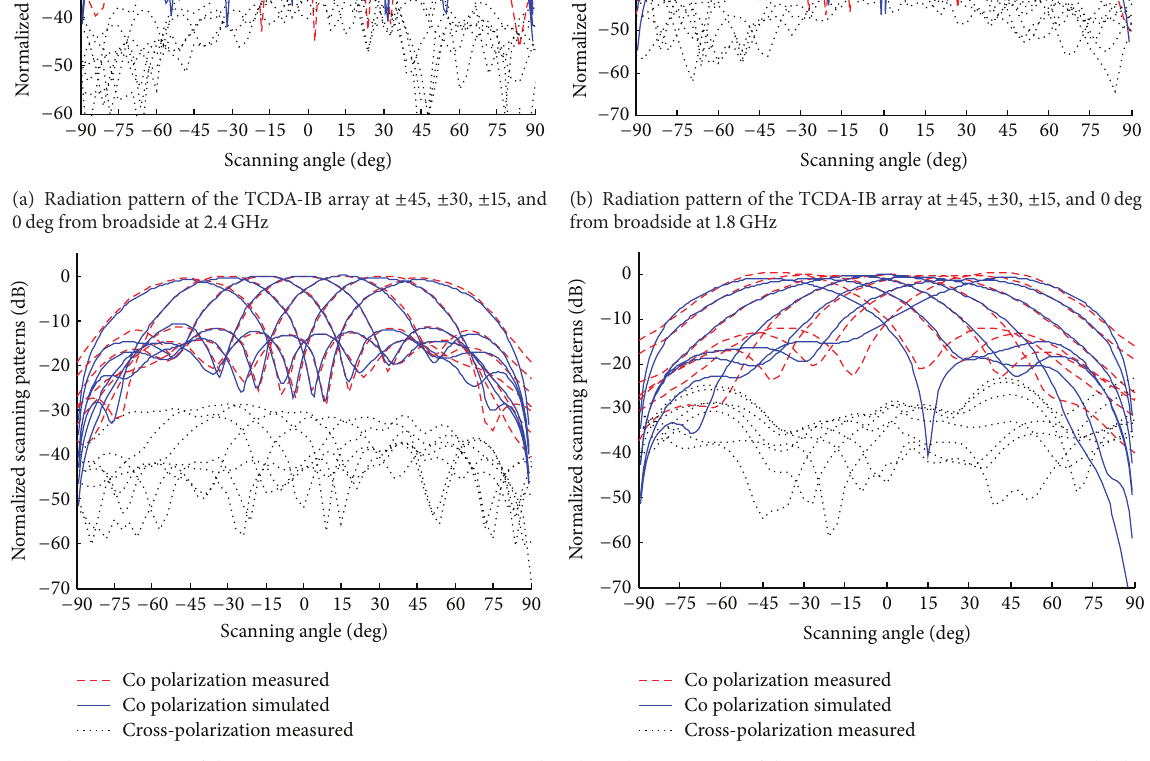
(c) Radiation pattern of the TCDA-IB array at ± 45, ± 30, ± 15, and (d) Radiation pattern of the TCDA-IB array at ± 45, ± 30, ± 15, and 0deg 0deg from broadside at 1.2GHz from broadside at 0.6GHz Figure 14: H-plane scanning for the TCDA-IB array defined in Figures 5–9. Comparison of the measured versus simulated patterns at various scan angles. The measured cross-polarization levels are also